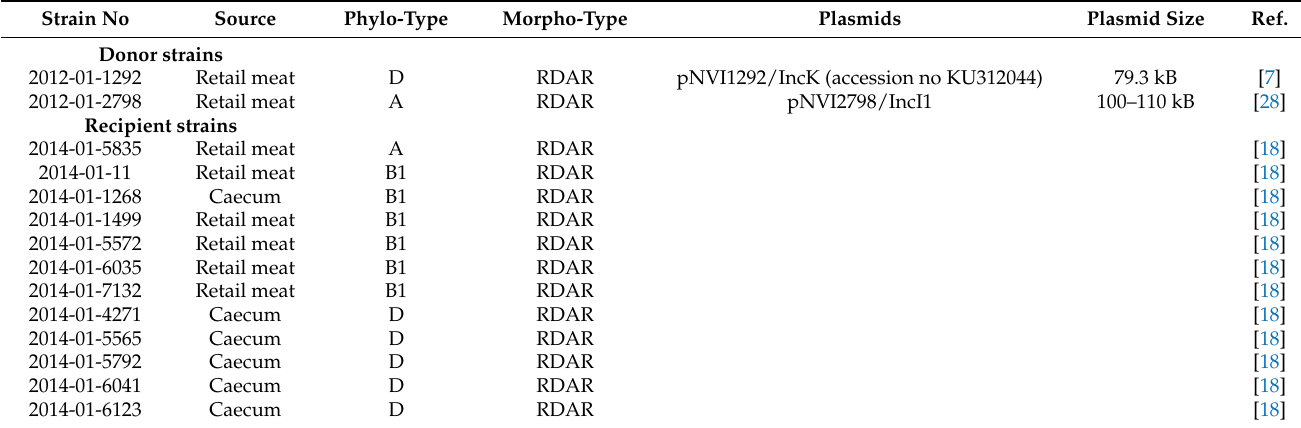
Table 1. Information on strains and resistance plasmids used in the conjugation